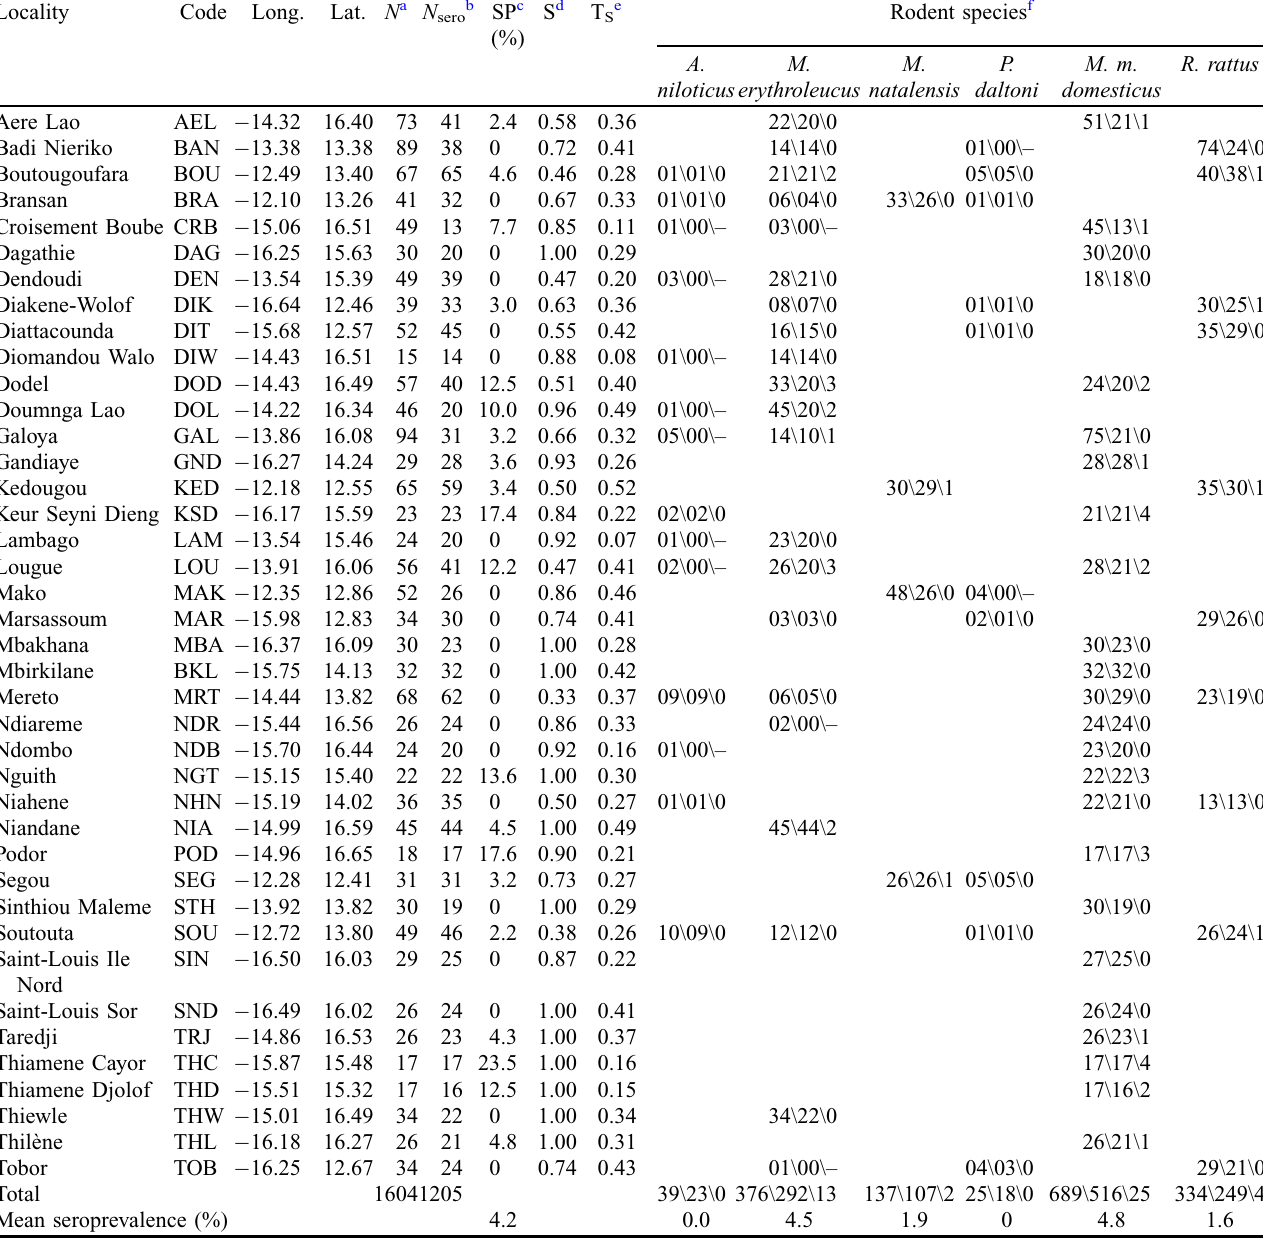
Table 1. Rodent sampling in Senegal, number of seropositive individuals for Toxoplasma gondii , and mean seroprevalence per locality and rodent